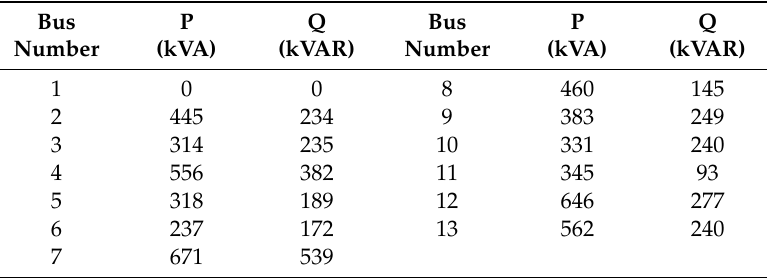
Table 4. Peak load demanded in the 13 buses of the DN.